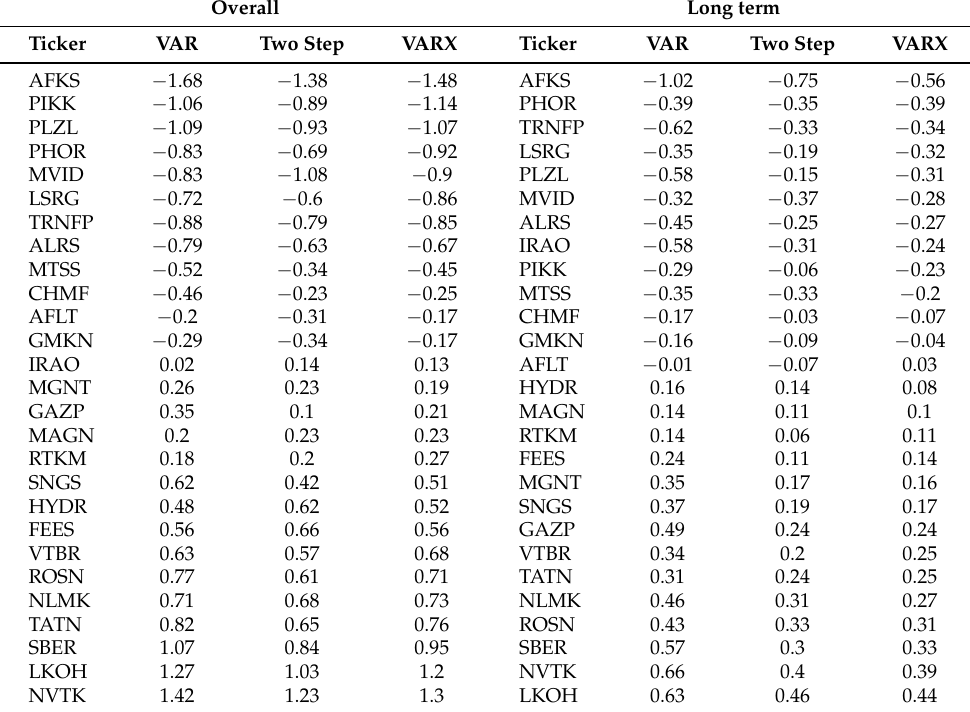
Table 4. Overall and long term NET